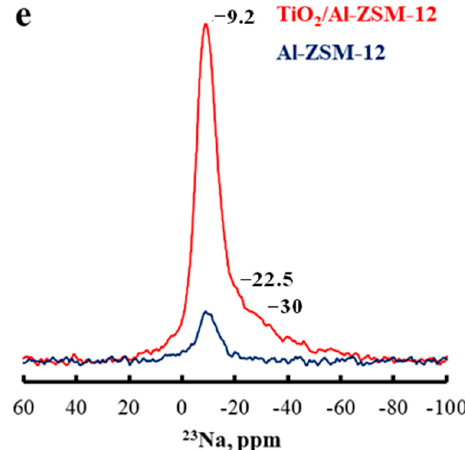
Figure 5. NMR spectra of the solid on ( a ) 27 Al, ( b ) 1 H, ( c ) 29 Si, ( d ) 1 H- 29 Si CP/MAS, and ( e ) 23 Na nuclei of synthesized zeolites.